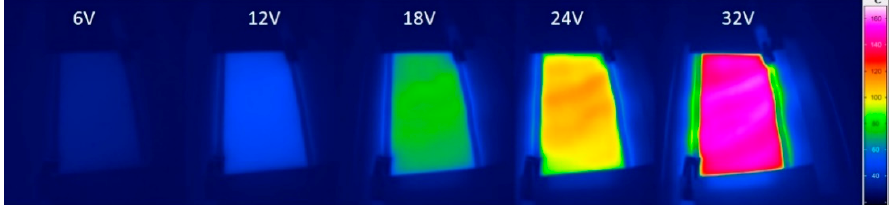
Figure 6. IR images of silicone/5% CNT composite with 5 cm electrode distance at different poten-